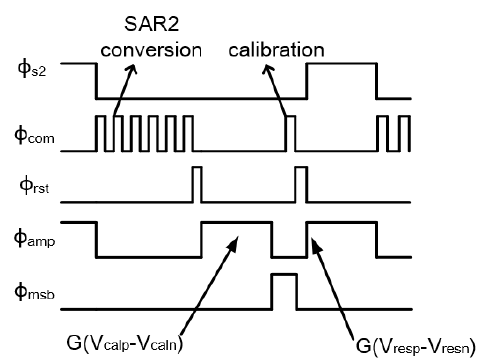
Figure 3. Operation timing of the background calibration .